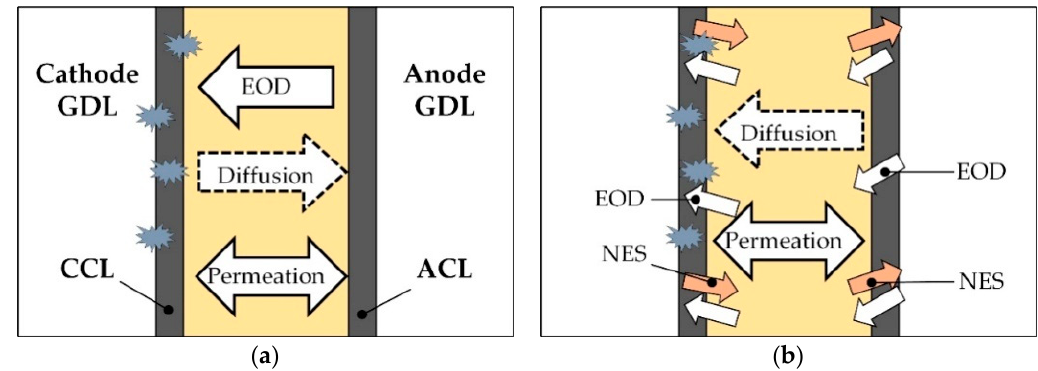
Figure 2. ( a ) Traditional view of membrane water transport. The stars denote water production in the cathode catalyst layer (CCL). ( b ) Alternative view of membrane water transport where the electro-osmotic drag (EOD) is a source/sink term of membrane water, and it is partly balanced by nonequilibrium sorption (NES). The difference between EOD and NES is the amount of water that diffuses through the membrane. Forward and backward diffusion are possible. In the alternative model, hydraulic permeation applies only to nondissolved water.